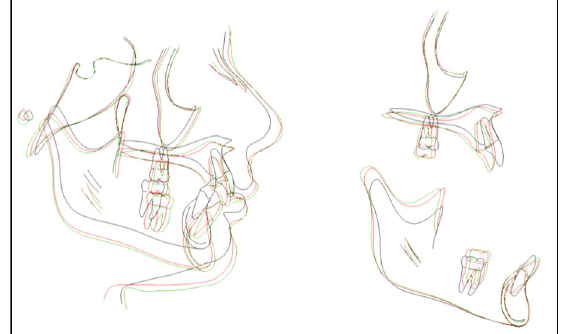
Figure 8: Superimposition of pretreatment (black), posttreatment (red), and follow up (green) lateral cephalograms.